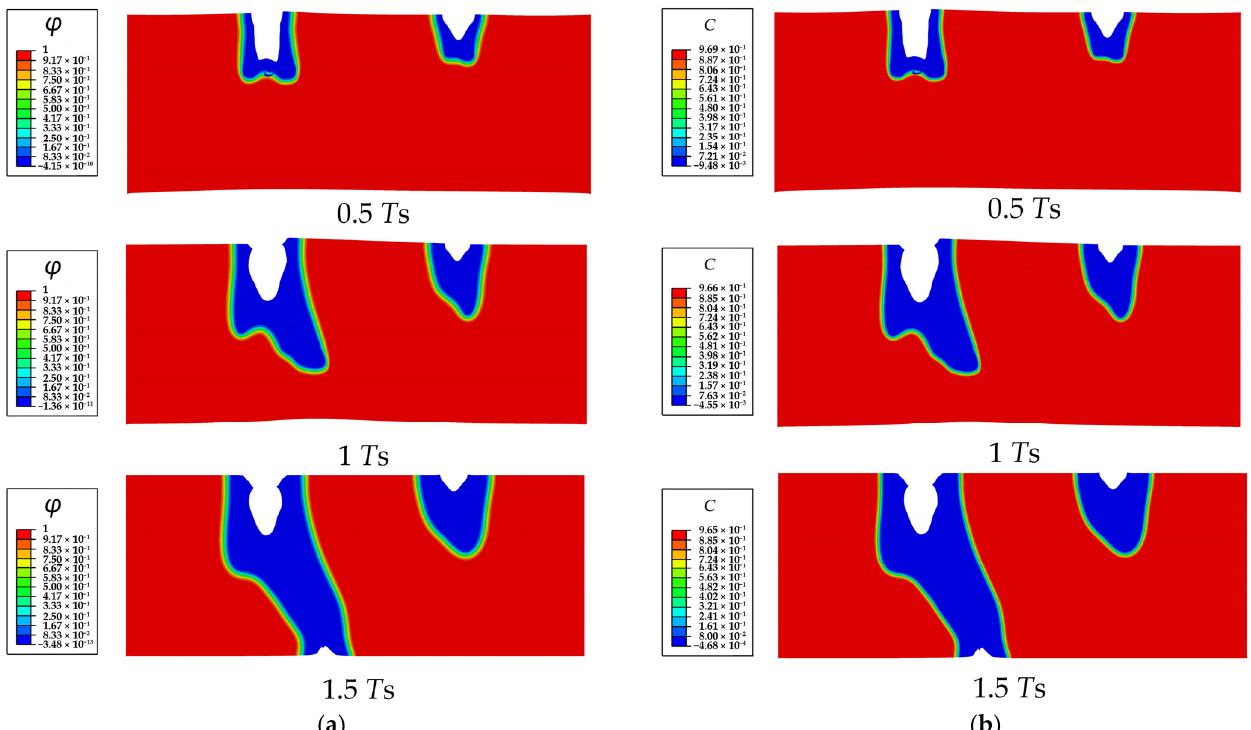
Figure 10. The SCCD process contours of a Mg single crystal without cavity: ( a ) phase field order parameter ϕ , ( b ) dimensionless concentration c .